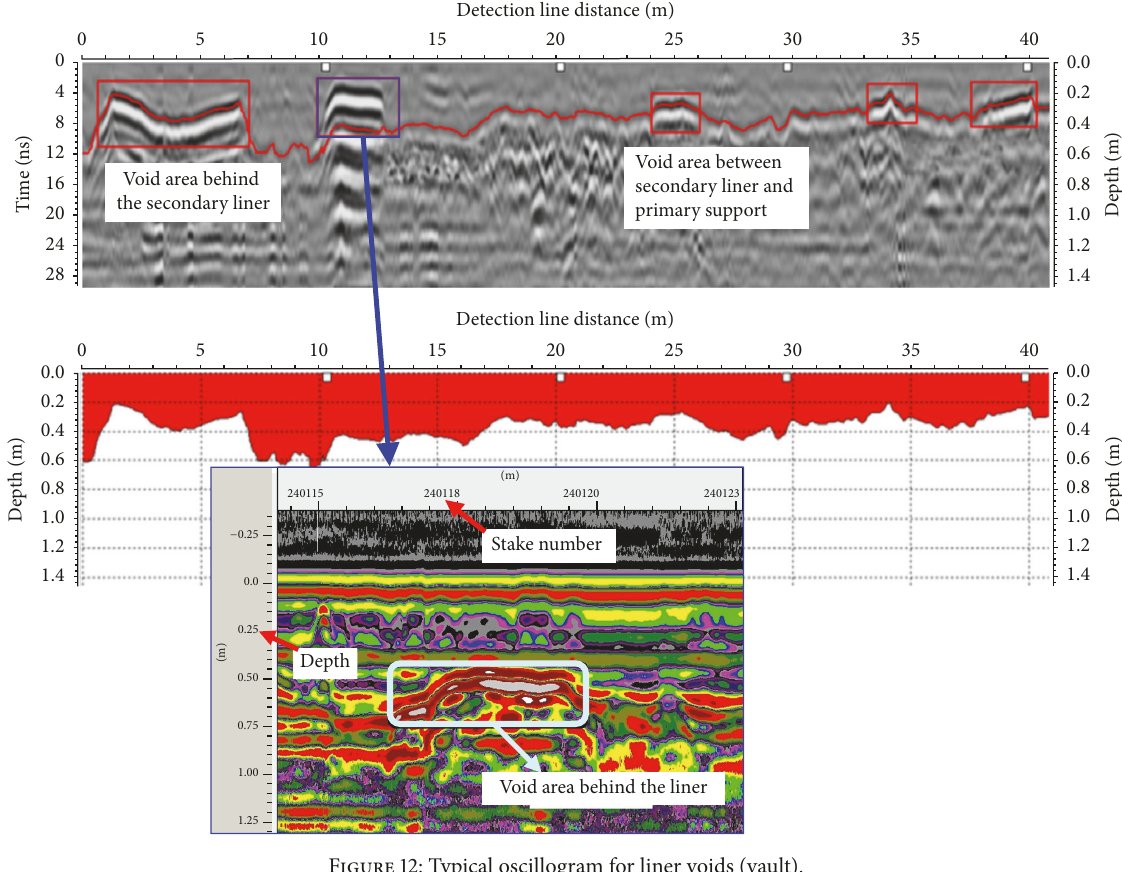
Figure 12: Typical oscillogram for liner voids (vault).